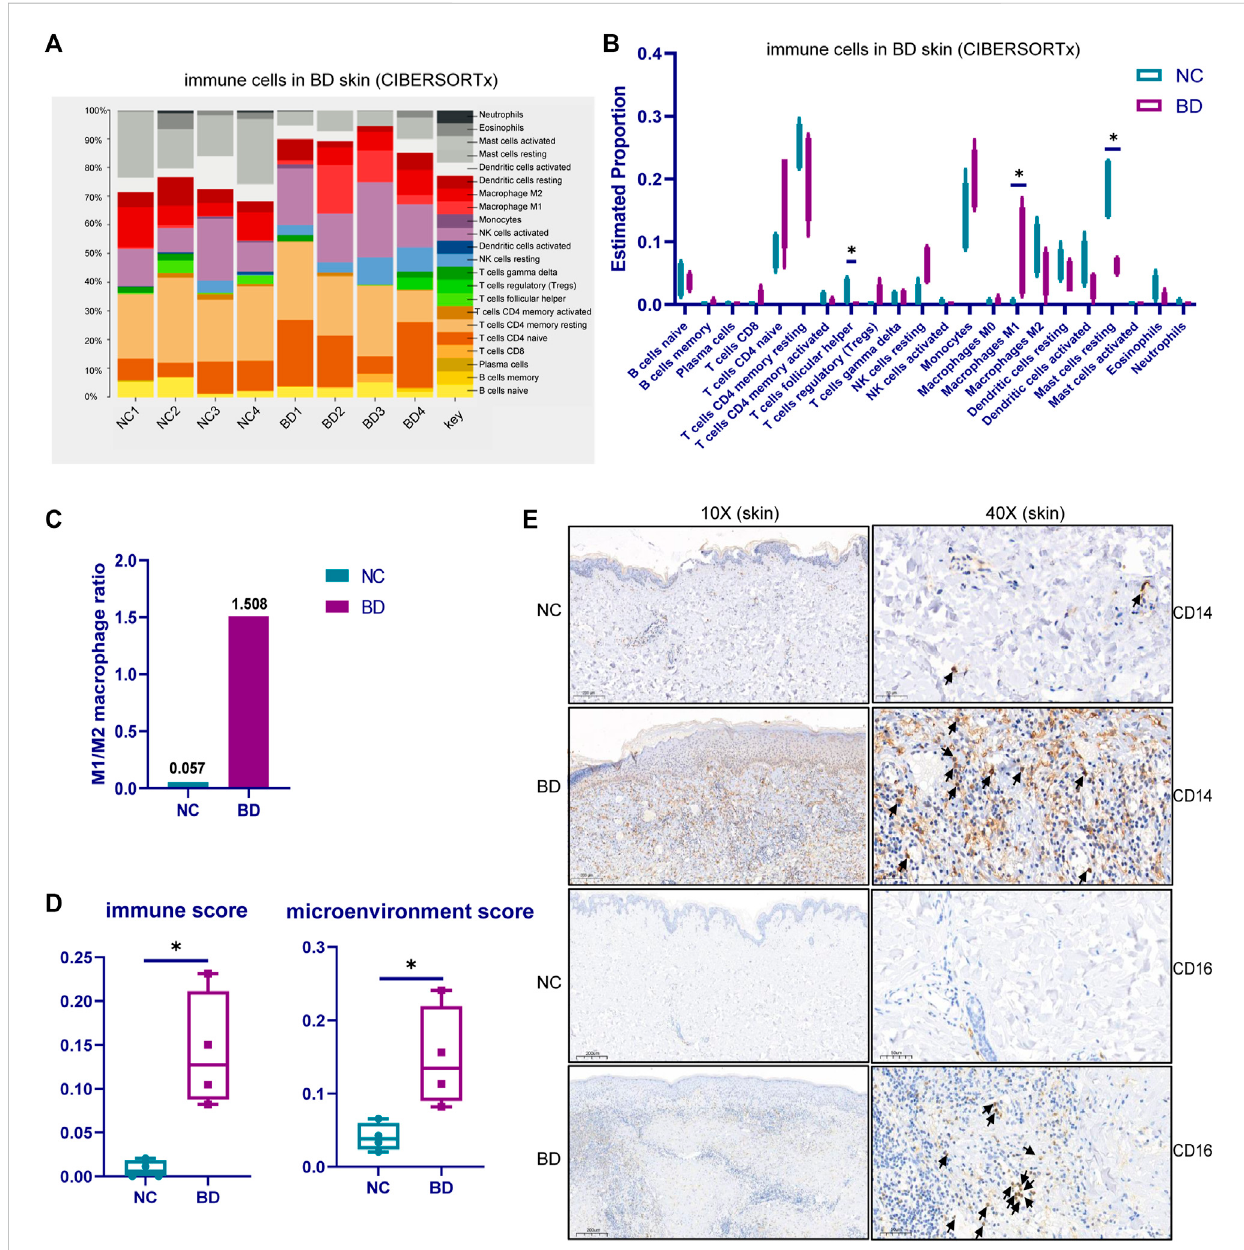
The immune cell subtypes in the skin tissue of BD. (A) CIBERSORTx analysis showing the cell composition of in fi ltrating immune cells in the skin of BDpatientsusingbulkRNA-seqdata. (B) Violinplotshowingthecellproportionof22kindsofcelltypesintheskinofBDpatientsandNCs. (C) Theratioof M1 and M2 macrophages in BD patients compared with NCs (D) xCELL analysis showing the immune score and microenvironment score of the BD patientsandNCs.TheWilcoxontestwasapplied,anda p -value < 0.05wasconsideredsigni fi cant. (E) IHCstainingshowingthemonocytetypeinthe skin of BD patients and